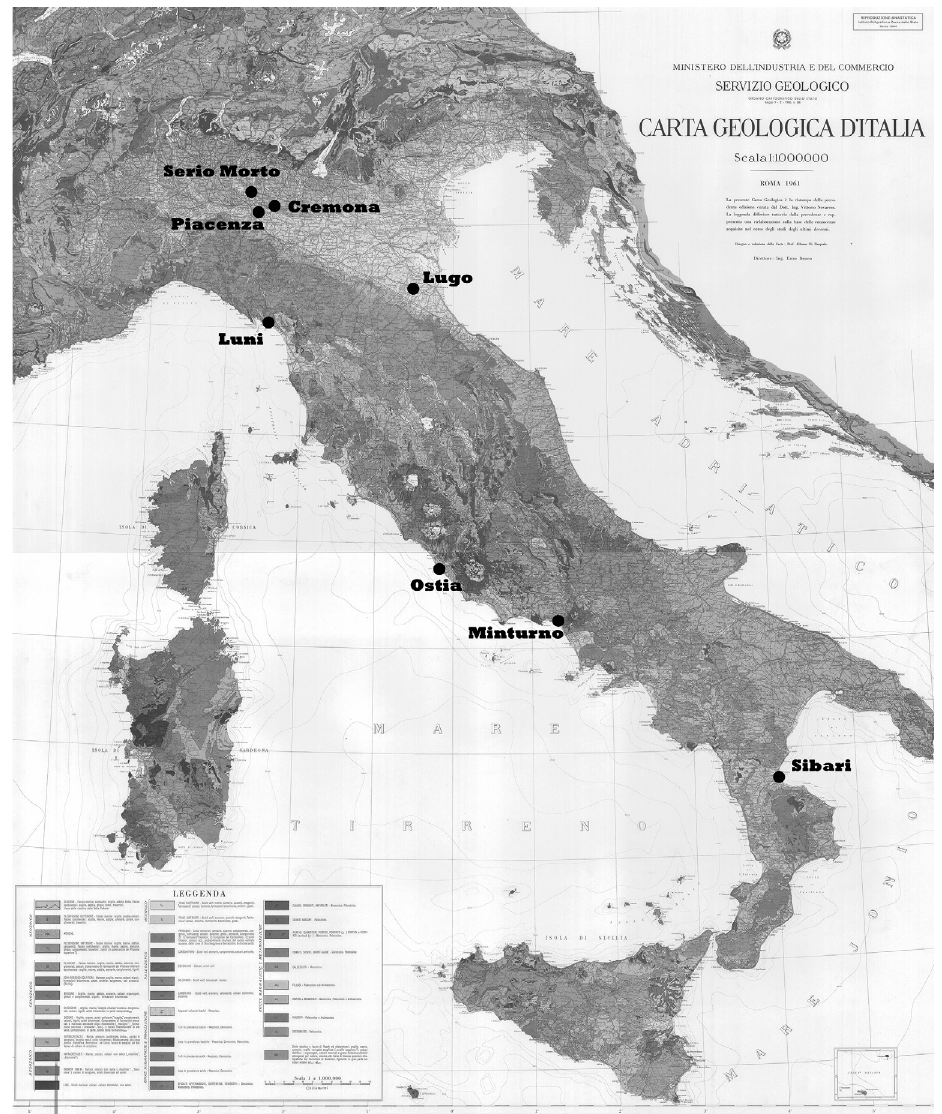
Figure 1: Map of the area mentioned in the